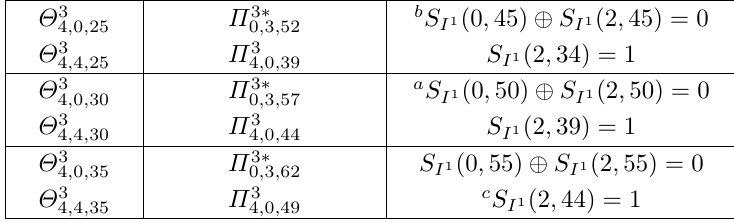
Table 6: 56 linearized sites (example with the starting column Π 3